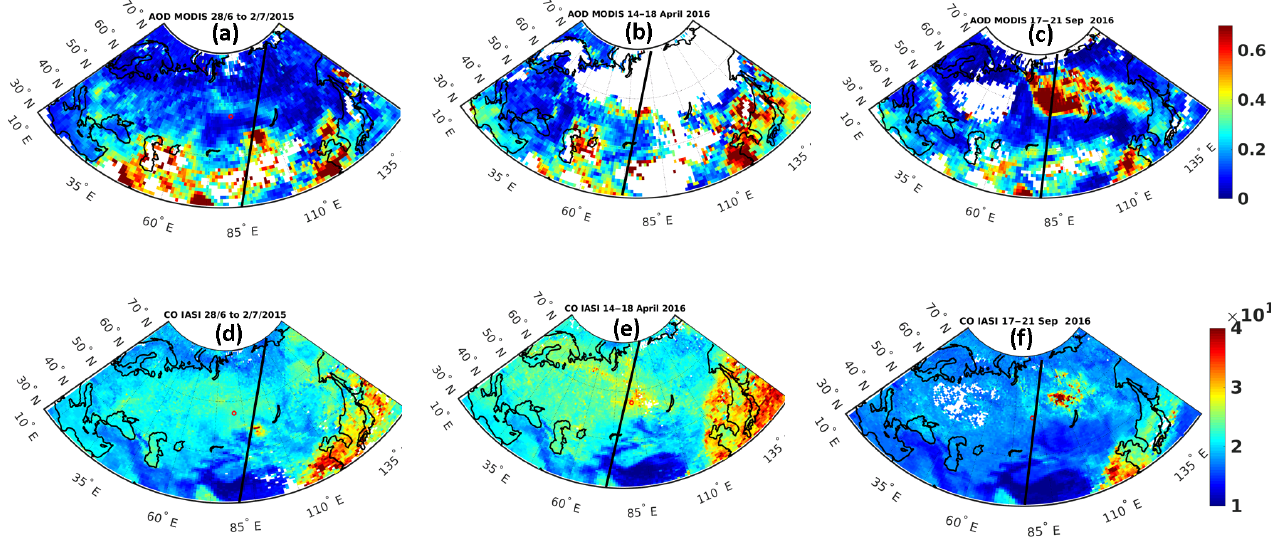
Figure 13. Five-day average of AOD at 532nm from 1 ◦ × 1 ◦ MODIS observations (a, b, c) and of CO in moleculescm − 2 from IASI observations (d, e, f) for July 2015 (a, d) , April 2016 (b, e) and September 2016 (c, f) . The red circle is Tomsk and the thick black lines are the CALIOP overpasses shown in Figs. 14 to 16.